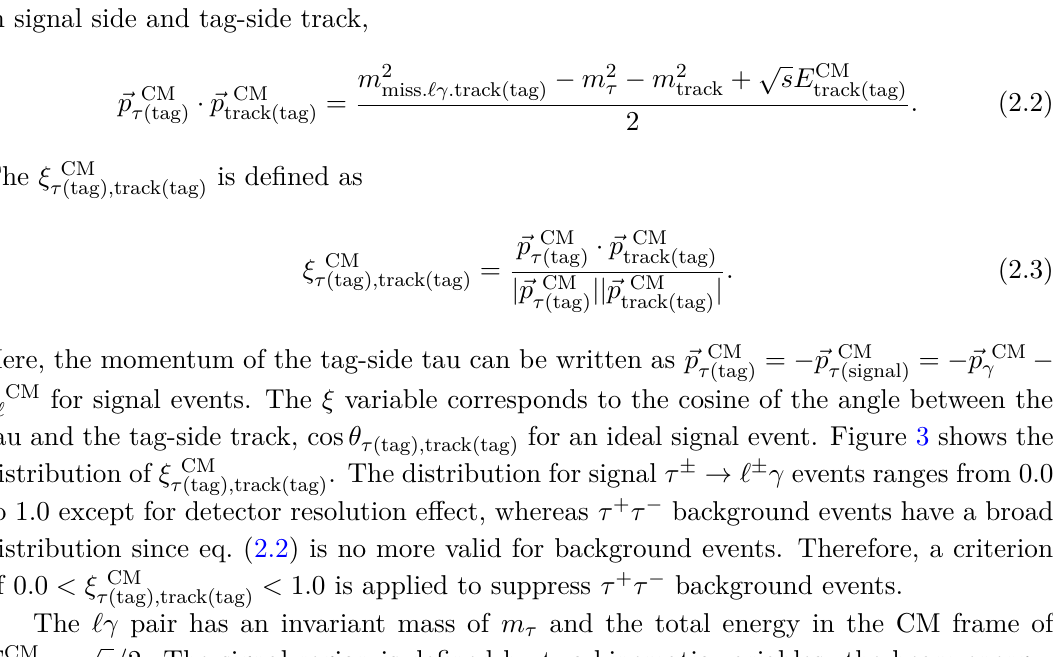
(a) τ ± → µ ± γ . (b) τ ± → e ± γ . Figure 2 . Distribution of missing-mass-squared on the tag side ( m 2 (b) τ ± → e ± γ channels. Events satisfying all selection criteria except for the m 2 M bc ∈ [1 . 73 , 1 . 85] GeV/ c 2 are plotted. The background MC samples are normalized to the cross section times integrated luminosity of 988 fb − 1 . The blue histograms show the signal MC samples with an assumed branching fraction B ( τ ± → ‘ ± γ ) = 5 . 0 × 10 − 7